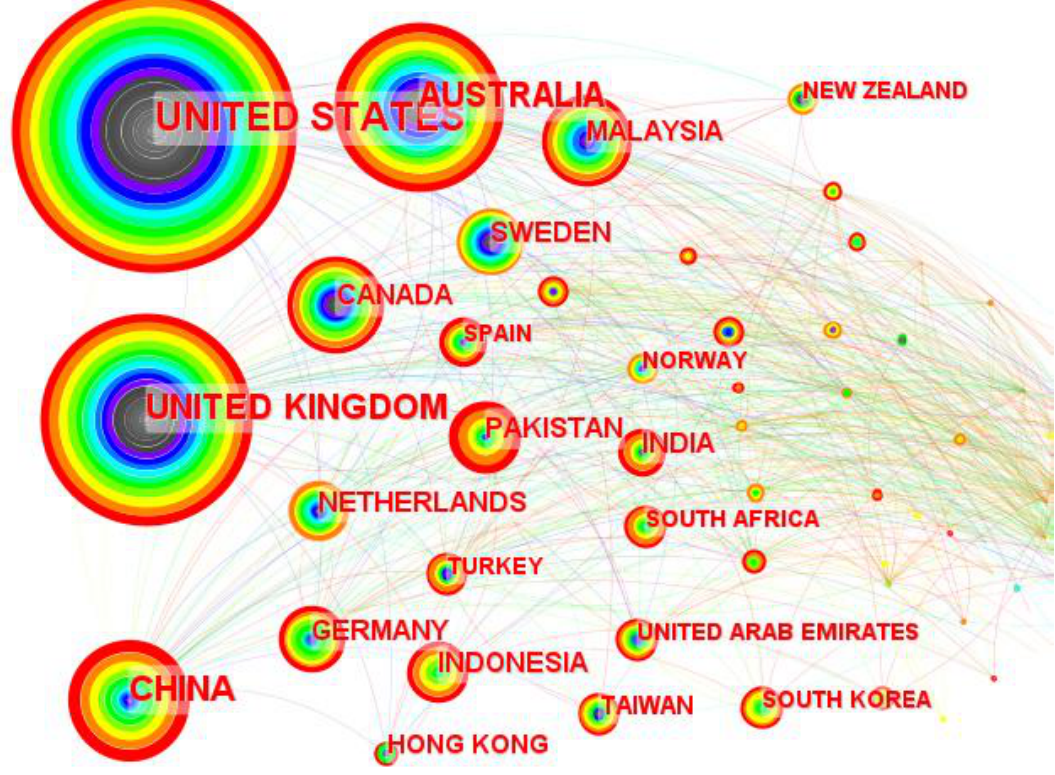
Figure 3. Country/region collaboration network.